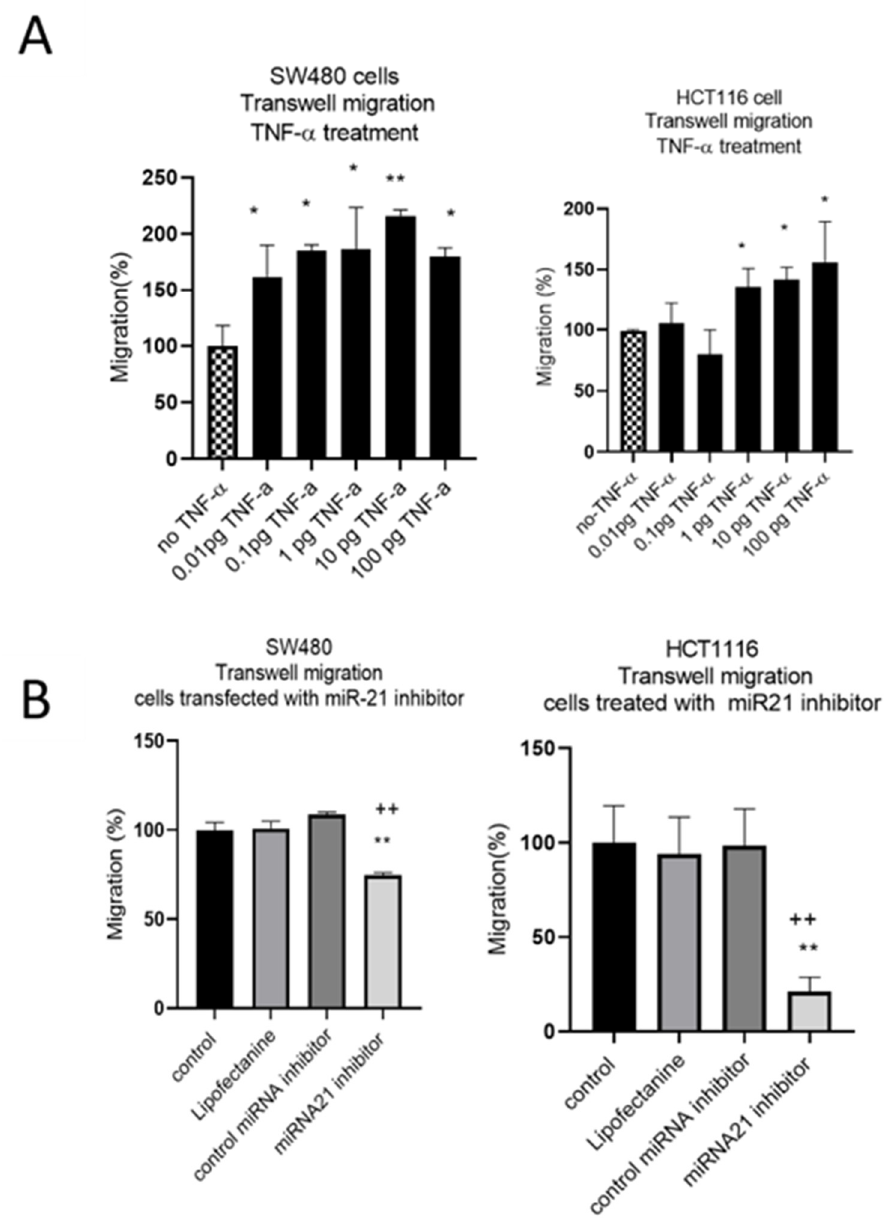
Figure 6. SW480 and HCT116 transwell cell migration ( A ) cells treated with TNF ‐α . Error bars represent the SEM for three independent cultures; ( B ) cells transfected with miR ‐ 21 inhibitor. Error bars represent the SEM for six replicates and two independent cultures. Significant differences were calculated using one ‐ way ANOVA followed by Dunnett’s test (GraphPad Prism 8). Statistical comparisons of TNF ‐α treatment vs . no TNF ‐α control, control vs. miR ‐ 21 inhibitor (* p < 0.05, ** p < 0.01), and control miRNA inhibitor vs . miR ‐ 21 inhibitor (++ p < 0.01).